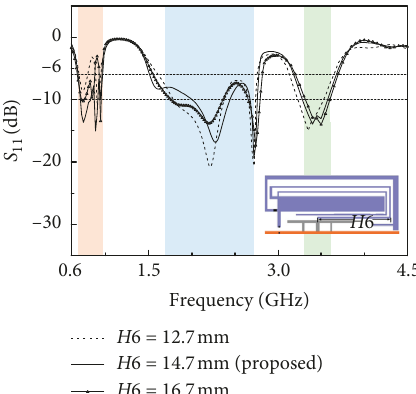
Figure 4: Simulated S 11 as a function of the length H 6 for the proposed